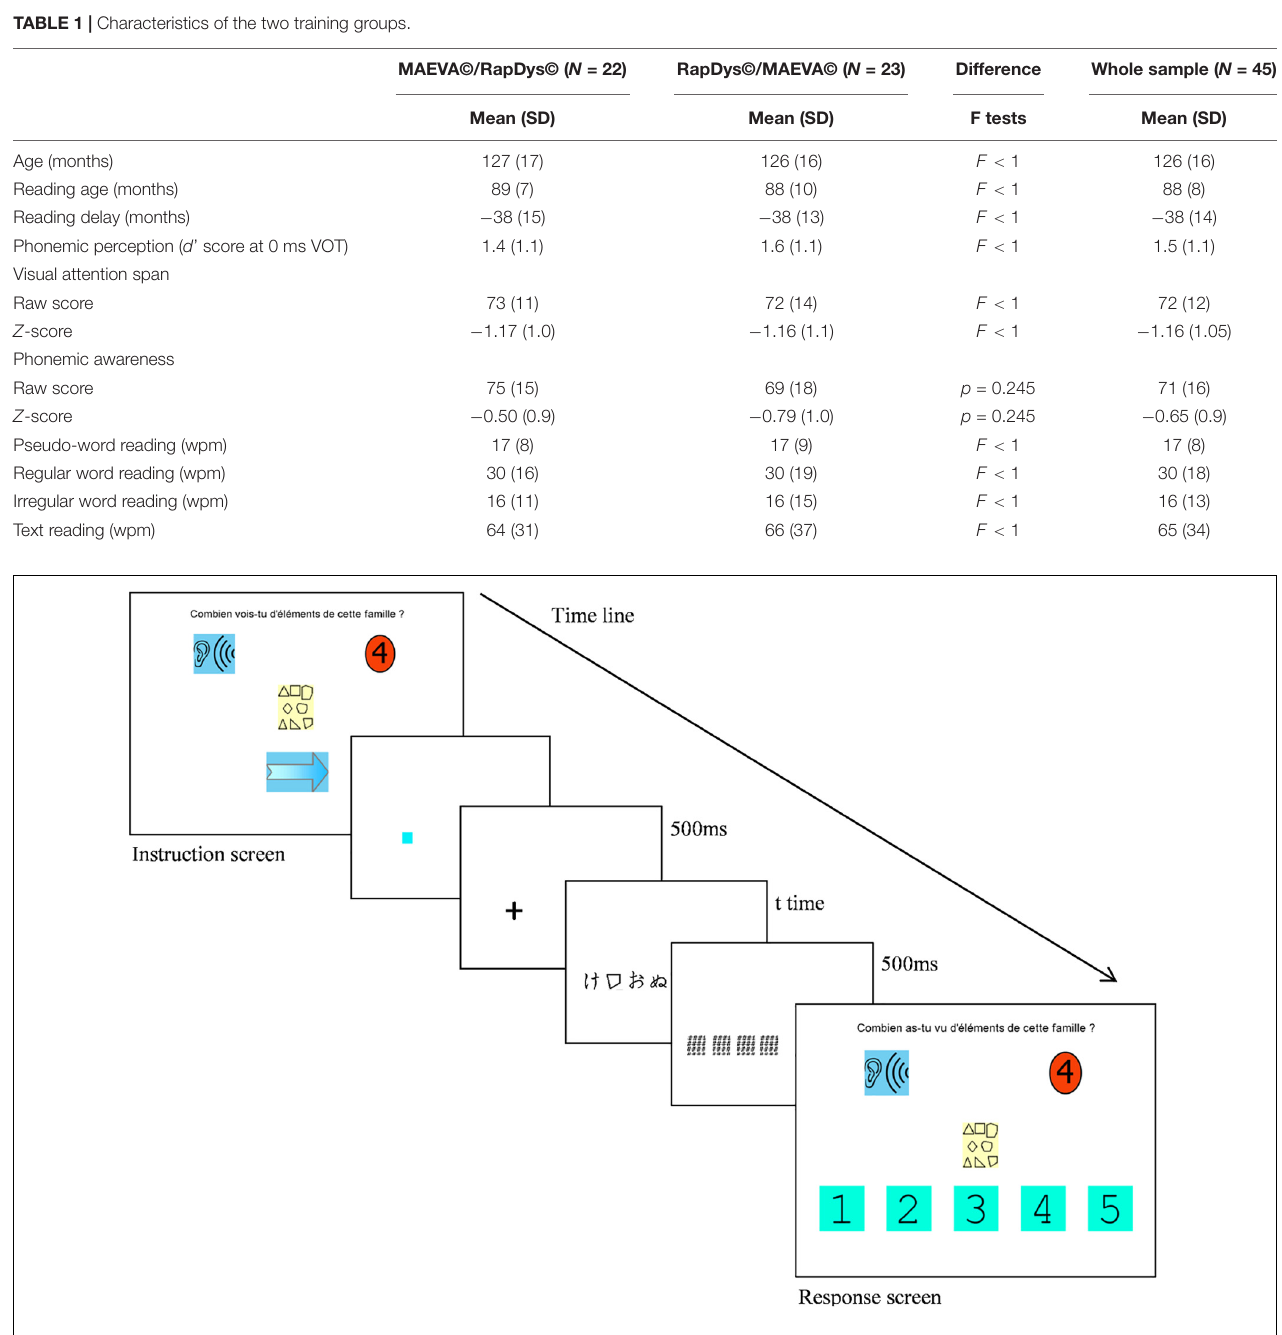
FIGURE 1 | Example of a trial for MAEVA© training. Instruction n ◦ 4 (How many elements of this family did you see?) is presented; T time is the presentation time defined by the